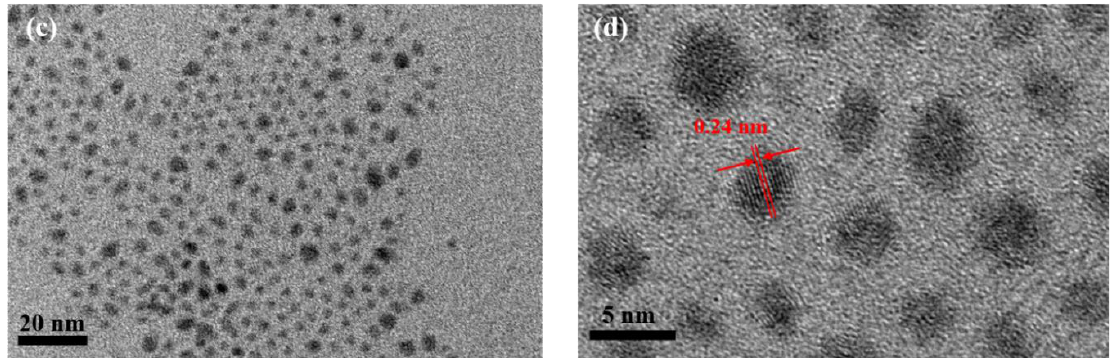
Figure 1. ( a ) Shows the absorbance spectrum of a 0.5 mg/mL Ag 2 S dispersion and a normalized PL emission spectrum of a 2 mg/mL Ag 2 S dispersion. The PL spectrum was excited with a wavelength of 550 nm. ( b ) Shows QDs at different concentrations: 2 mg/mL (left) and 30 mg/mL (right). ( c ) Shows a TEM image of the synthesized nanocrystals, while ( d ) is an HR-TEM image of the same sample, showing the distance between two planes in one of the